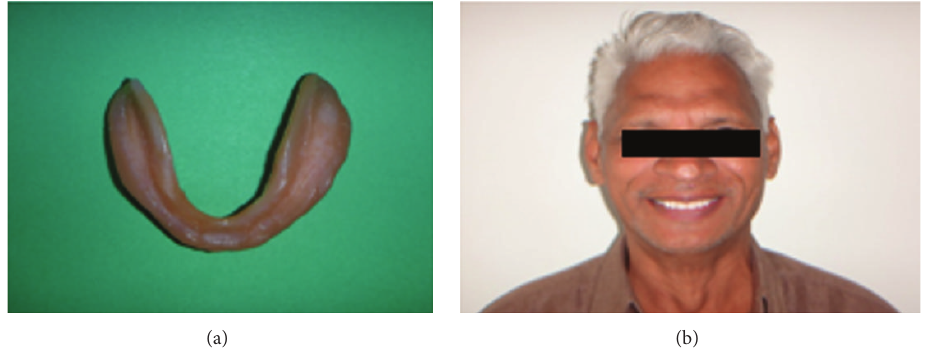
Figure 11: Relined mandibular denture and pain-free satisfied